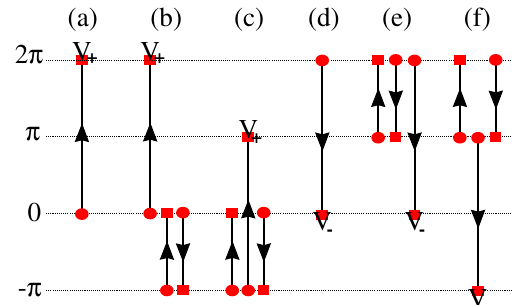
FIG. 13. (a) – (c) Pictorial representation of Eq. (B42), with solid line indicating a product of projections that is path ordered according to the arrow on the same line, and V indicating an insertion of the spatial-embedding matrix V ð 2 π ~y Þ . Panels (d) – (f) represent Eq. (B52), with V of V ð − 2 π ~y Þ